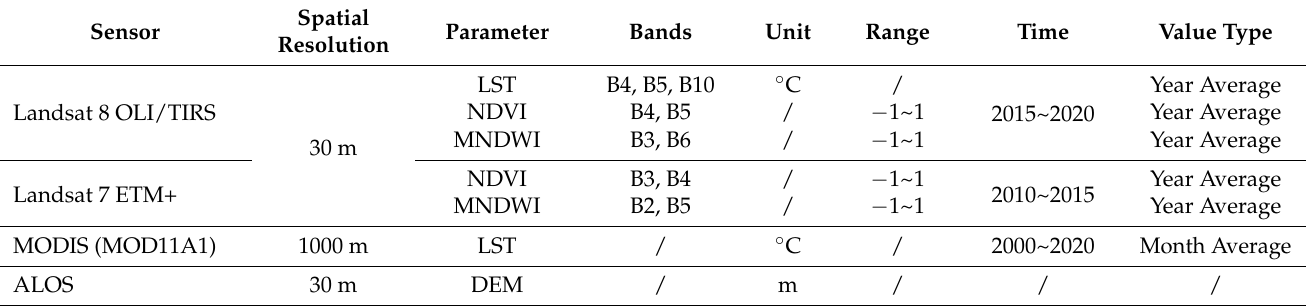
Table 2. Optical and DEM data parameters used in this